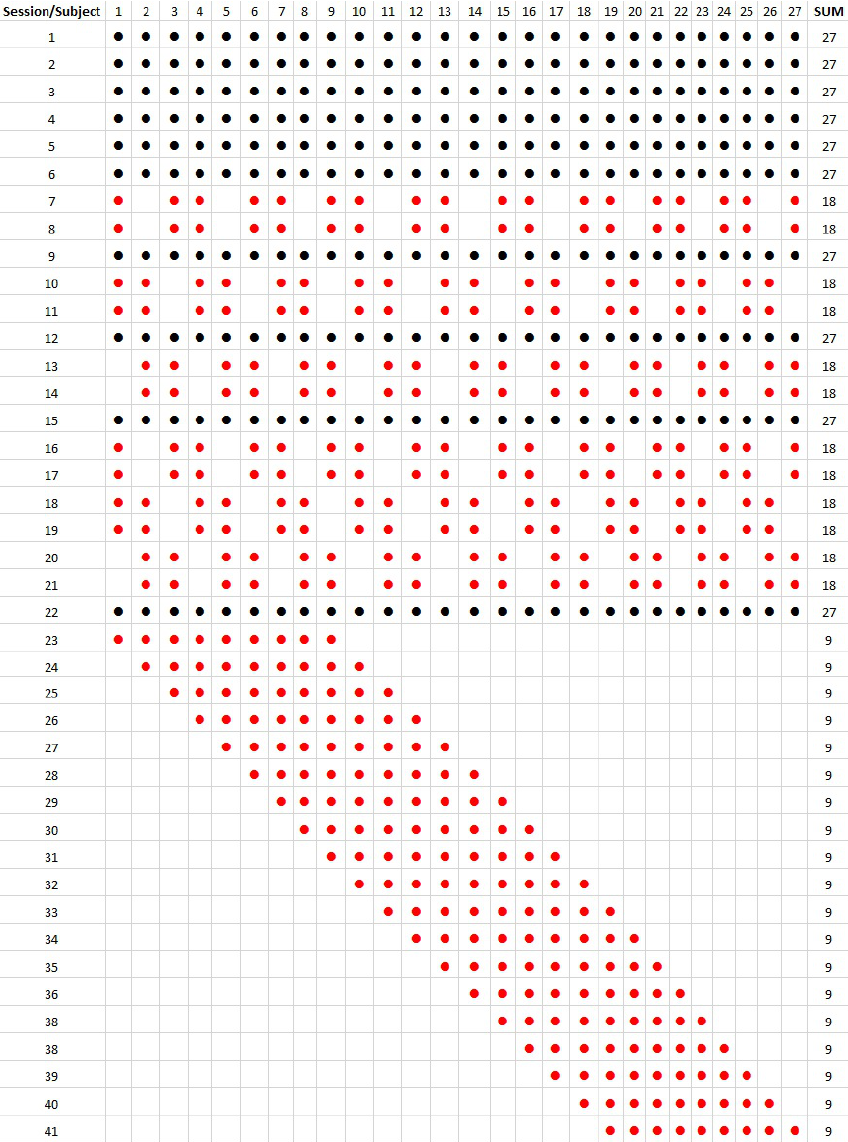
Figure 6. Graphical representation of the test sessions. Each column represents one subject, and each row corresponds to a session. Black dots refer to mandatory sessions evaluated by all 27 subjects. Red dots refer to non-mandatory sessions distributed among the subjects equally. Each 2-channel and 4-channel session was evaluated by 18 subjects, and each 8-channel session by 9 subjects. The last row shows the total number of sessions for each subject varying between 19 and